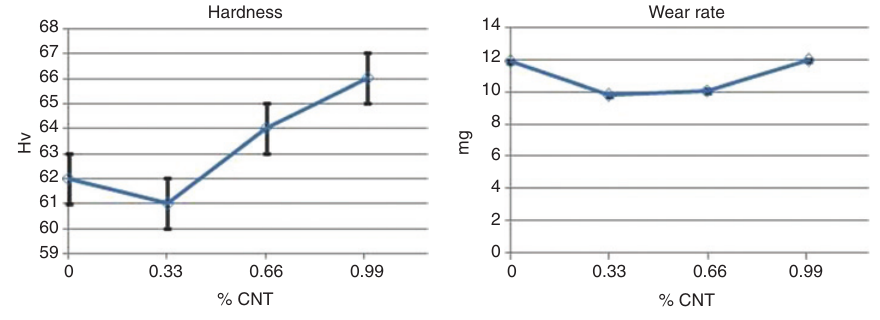
Figure 7 Hardness and wear rate